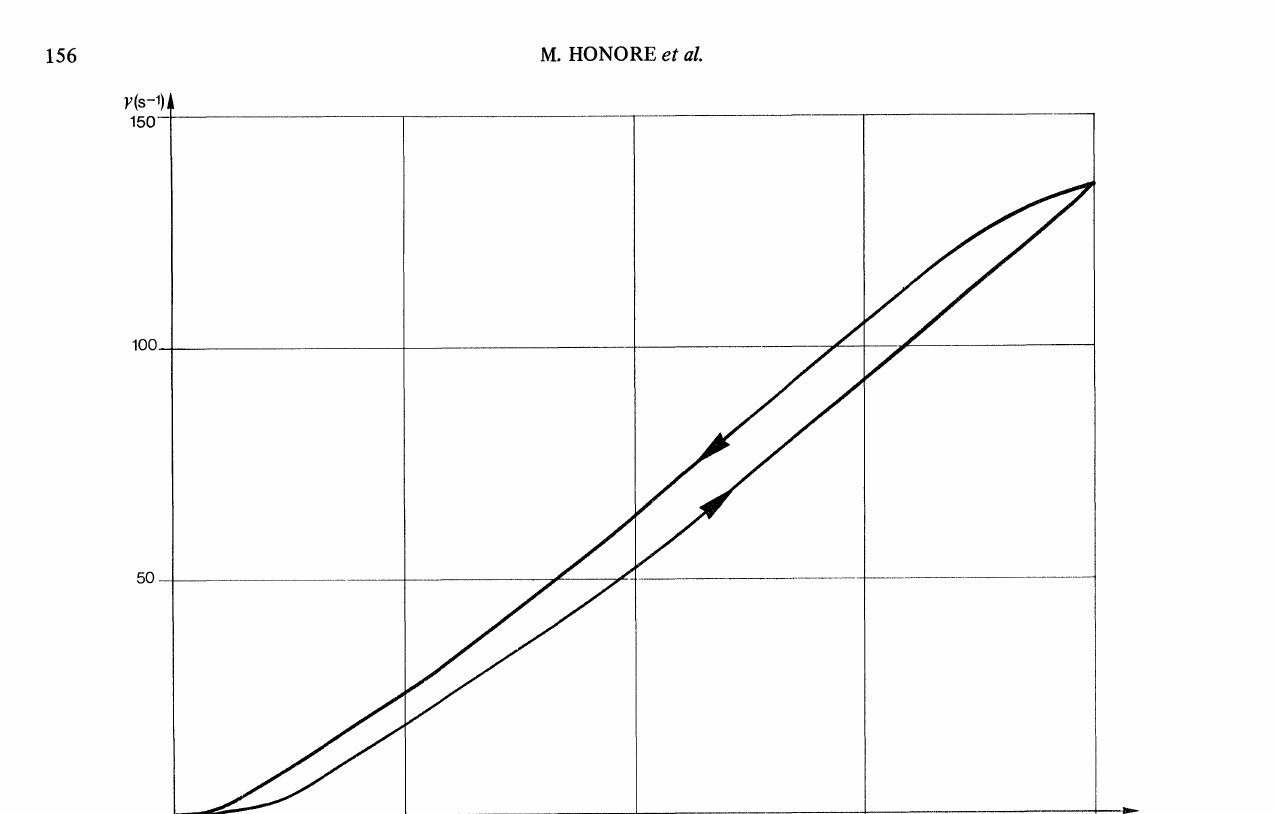
10 20 30 40 "(Pa) FIGURE 3 Thixotropic behaviour of the same paste as in Figure 2 with shear rate (/) as a function of shear stress